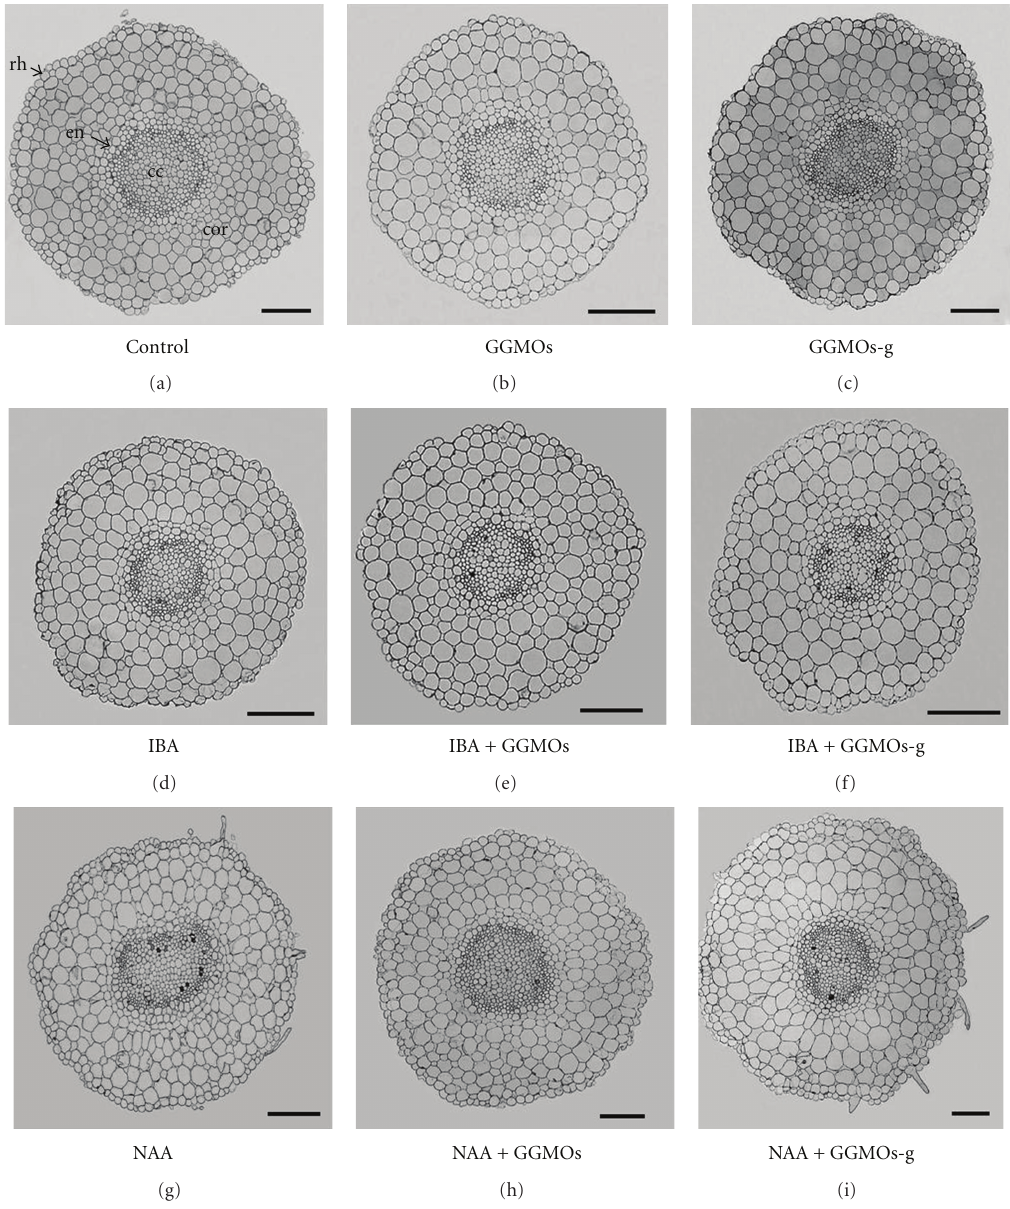
Figure 3: Cross sections of mung bean adventitious roots. Control—without any plant growth regulators, rh—rhizodermis, cor—cortex, en—endodermis, cc—central cylinder, bar = 100 μ